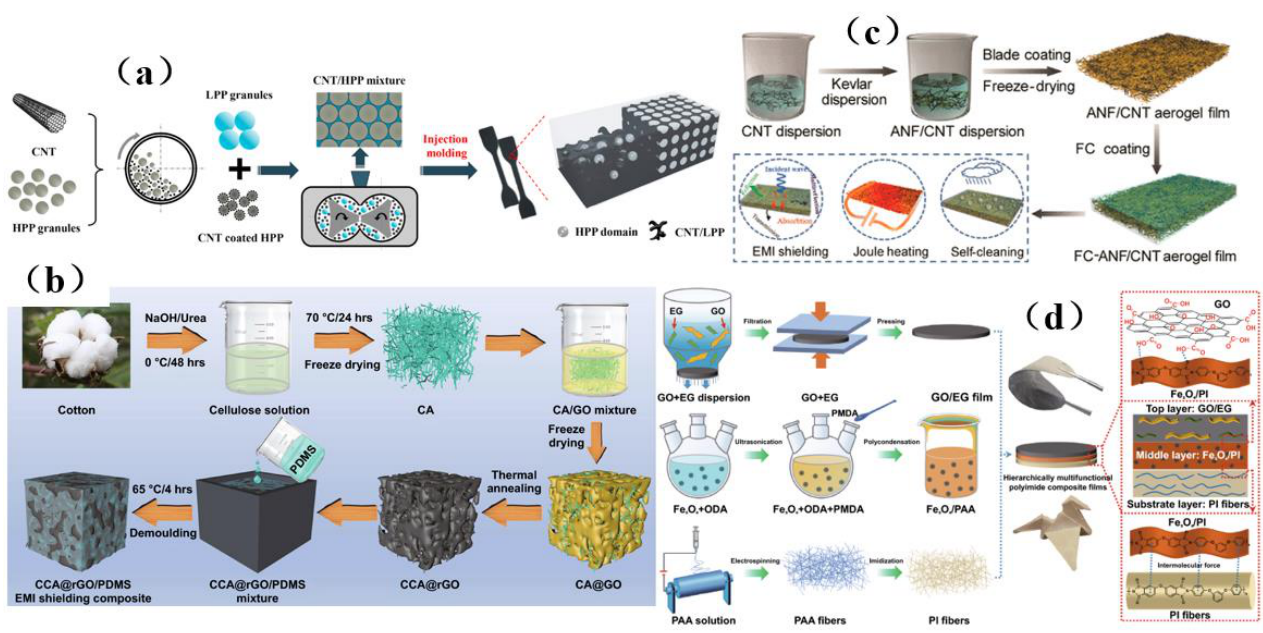
Figure 18. ( a ) Schematic diagram showing the preparation of separated carbon nanotubes/polypropylene composites and their performance evaluations [141]. Copyright 2020, Elsevier. ( b ) Schematic diagram of the manufacturing process leading to CCA@RGO/PDMS electromagnetic interference shielding composite material [142]. Copyright 2021, SpringerOpen. ( c ) Schematic di- agrams showing the preparation, and multifunctional characteristics of FC-ANF/CNT mixed gas gel membrane [45]. Copyright 2019, Elsevier. ( d ) Schematic diagram of preparation process of PI composite membrane [143]. Copyright 2020, American Chemical